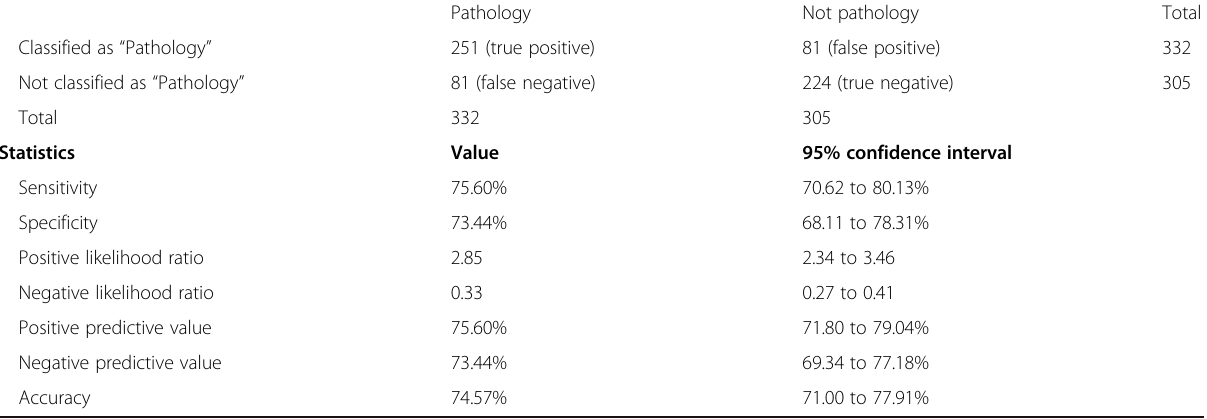
Table 3 Evaluation of model performance in detecting “ Pathology ” chest radiographs